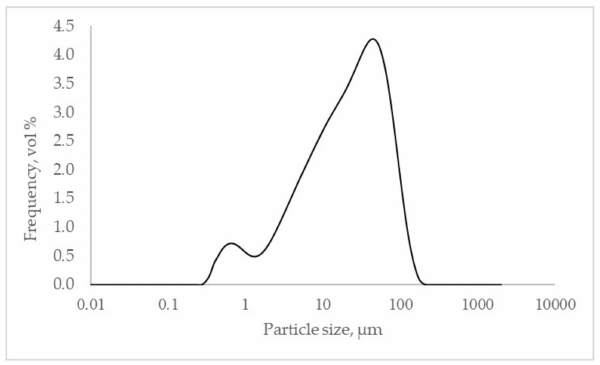
Figure 1. Granulometric distribution of milled